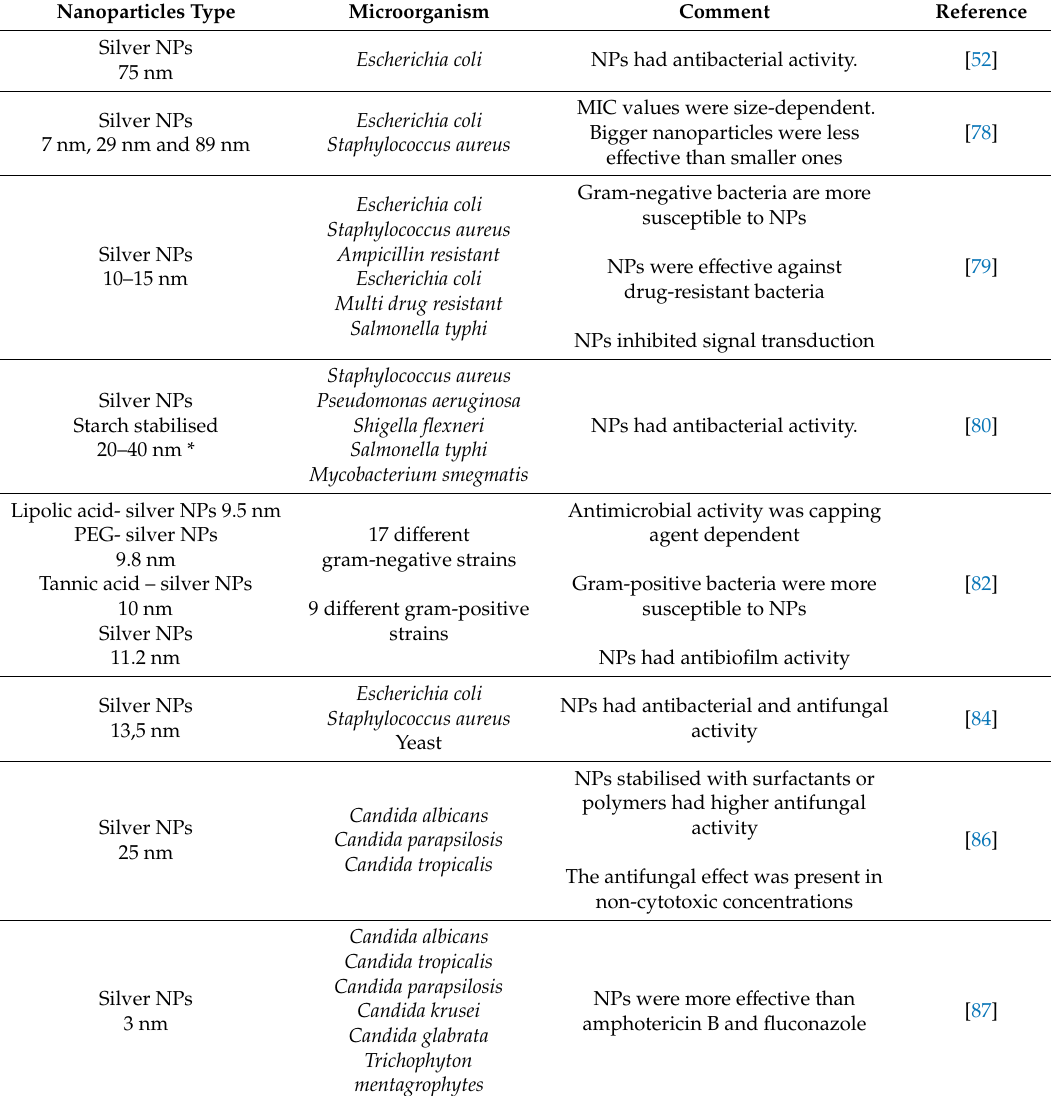
Table 4. Summary of antimicrobial activity of